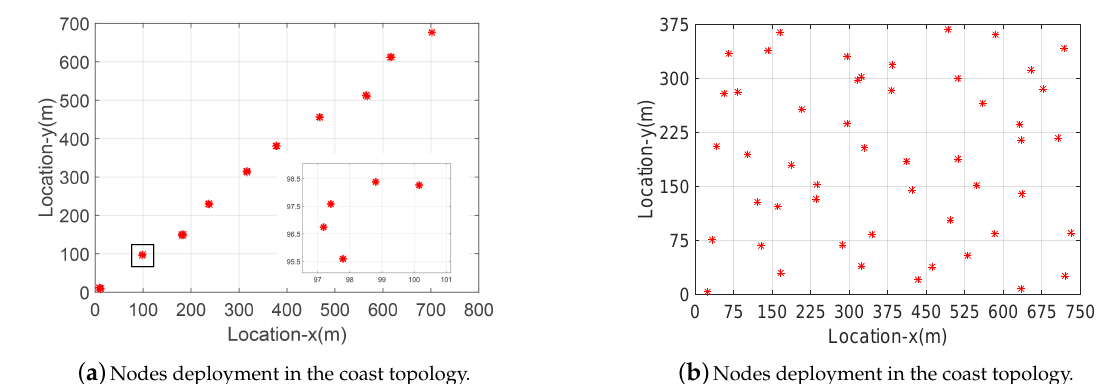
Figure 14. Nodes deployments in the large-scale simulations.